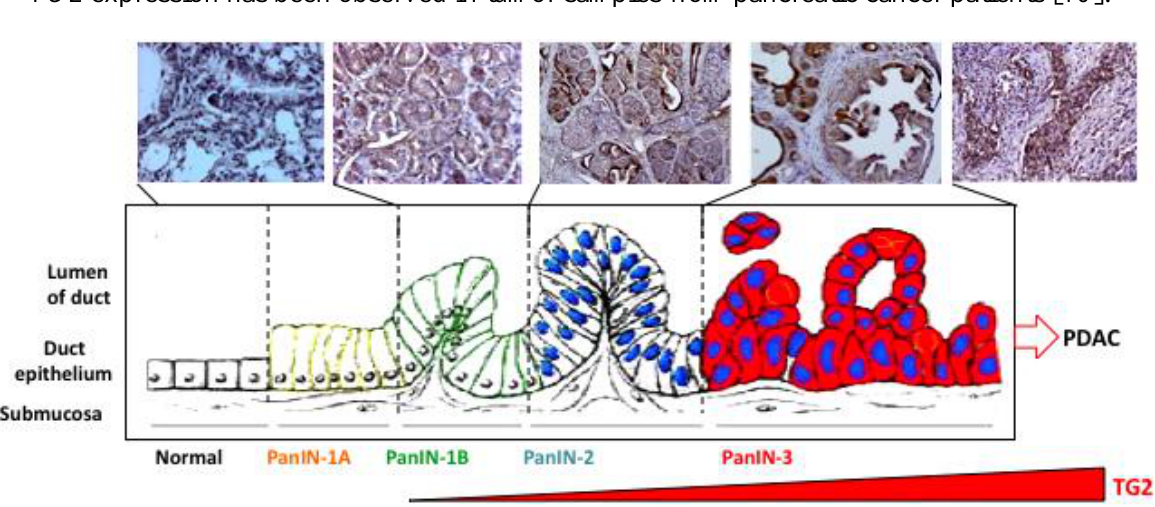
Figure 2. Progressive increase in TG2 expression during the course of pancreatic cancer progression in mice carrying pancreas-specific oncogenic K- ras K12D . A similar increase in TG2 expression has been observed in tumor samples from pancreatic cancer patients